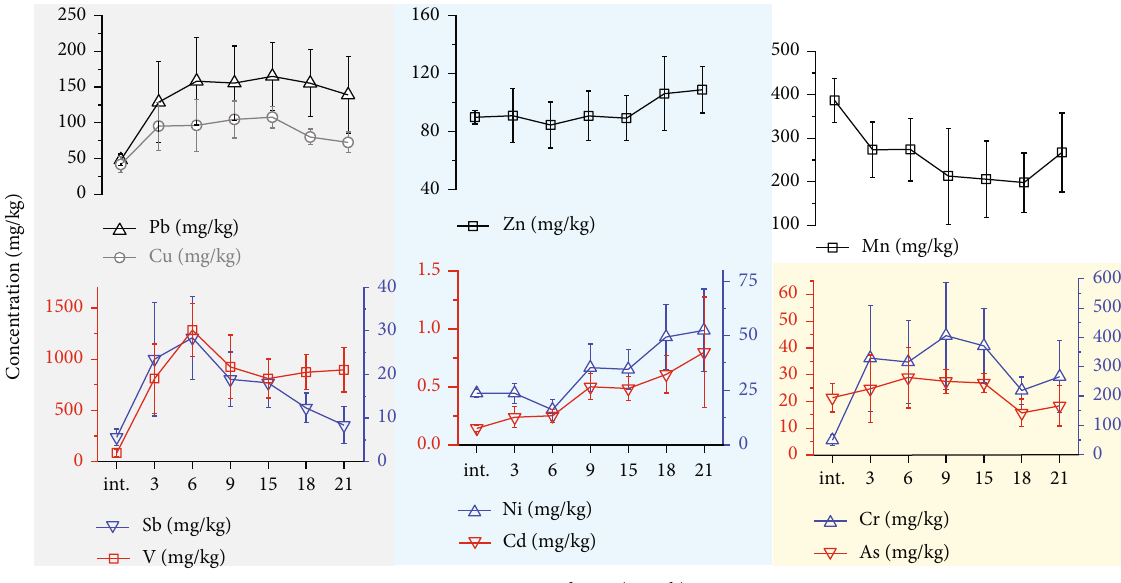
Figure 2: The concentrations of heavy metal in initial substrate material (init.) with recovered time. The same background color indicates the same change